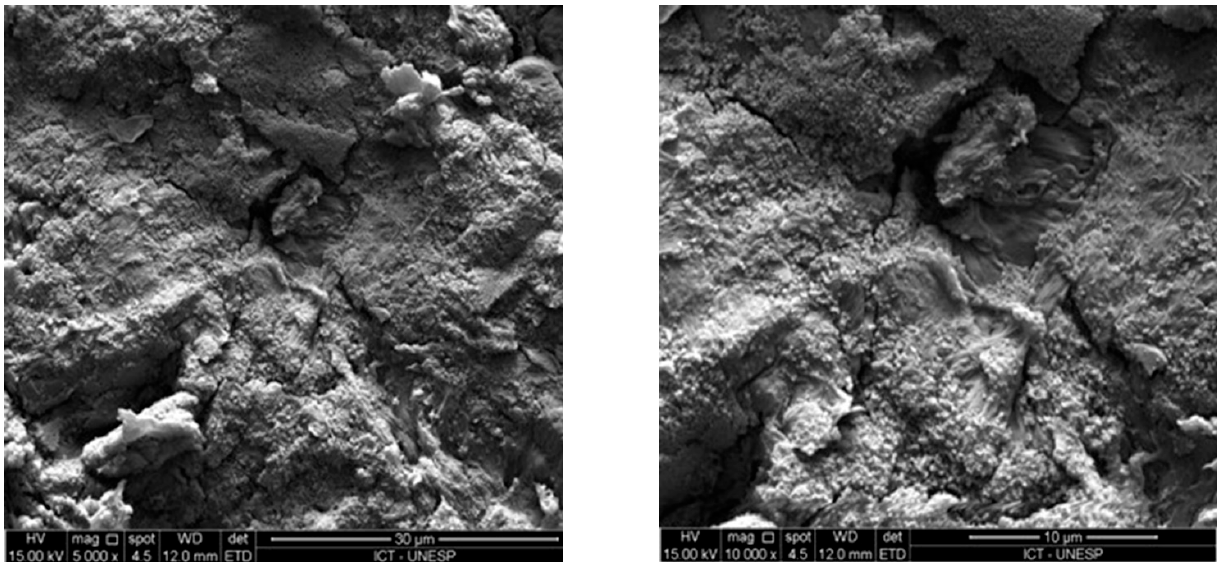
Figure 6. Tribochemical silica coating group (TBS). A rough surface resulted from using the silica deposition technique, where the roughness previously created using aluminum oxide sandblasting was later coated with silica. Magnification: 5000× and 10,000×.